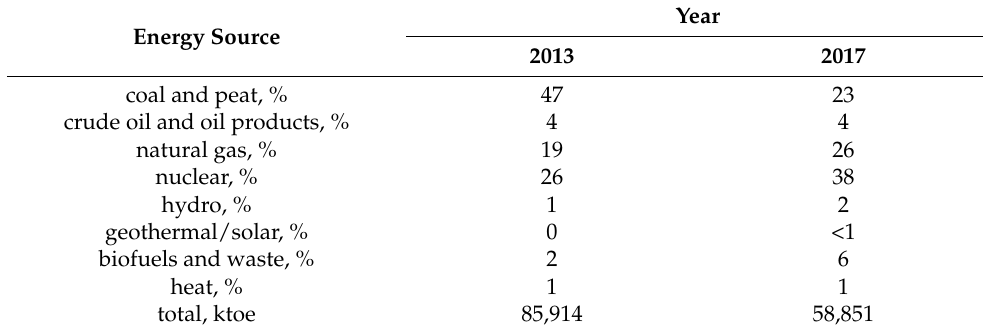
Table 1. Ukraine’s energy production in 2013 and in